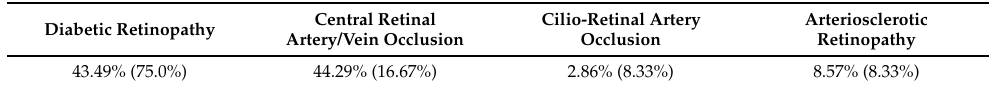
Table 3. Per class classification accuracy expressed as a percent of the correct diagnoses per diagnostic class. In parentheses, next to each accuracy, there is an image count per diagnosis in the survey dataset (expressed in percentages of overall images).